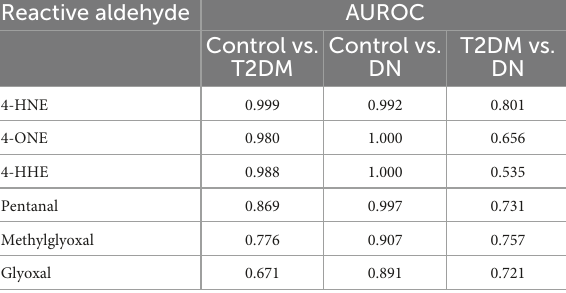
TABLE 4 Area under the receiver operator characteristic comparing urine reactive aldehydes: Control vs. type-2 diabetic mellitus